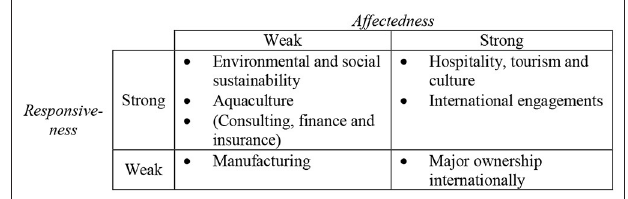
FIGURE 1 | A two-by-two